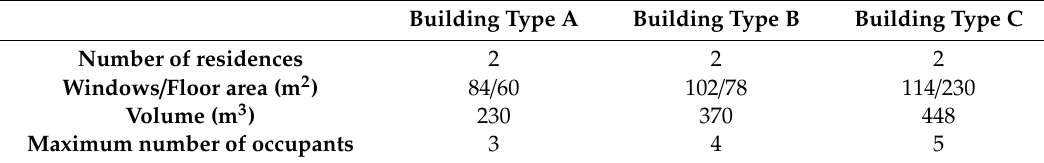
Table 1. Description of residential building’s